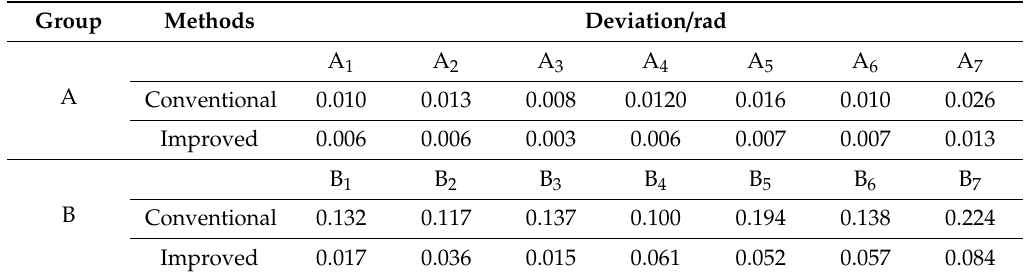
Table 1. Deviation comparisons with both